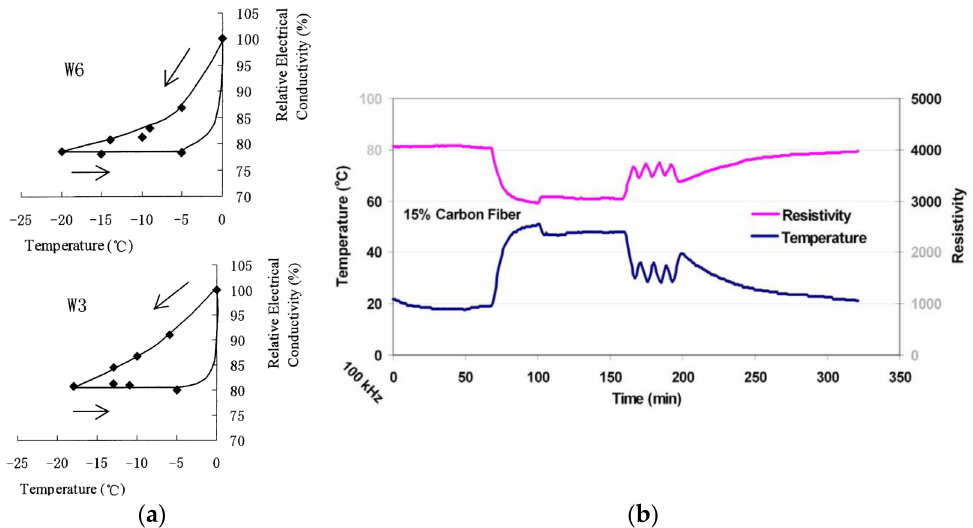
Figure 14. ( a ) Below zero temperature variation; ( b ) above zero temperature variation. Reproduced with permission from [68], Elsevier, 1998. Reproduced with permission from [69], University of British Columbia, 2008.